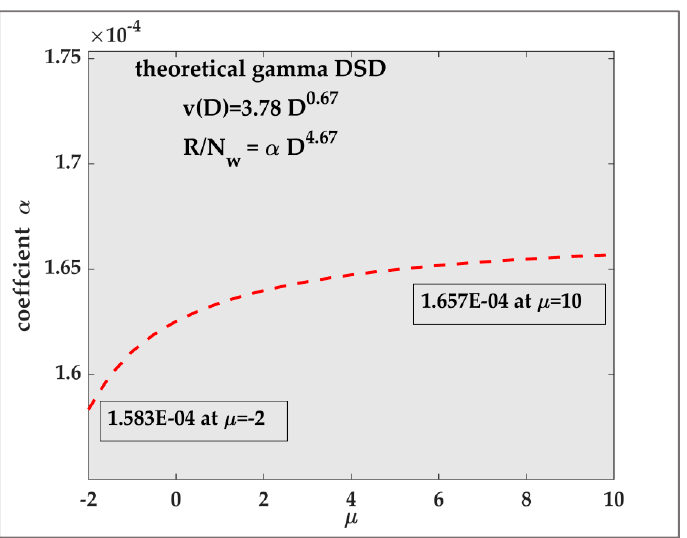
Figure 6. The coefficient α versus shape factor μ for a theoretical gamma with fall speed power law v(D) in m s − 1 , D in mm, R in mm h − 1 , and N W in mm − 1 m − 3 . Values of α are given within textboxes for μ = − 2 and μ = 10.